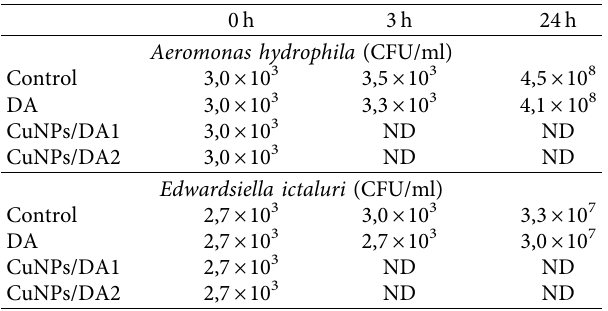
Table 2: Te antibacterial activity of CuNP/DA against A. hydrophila and Ed. ictaluri